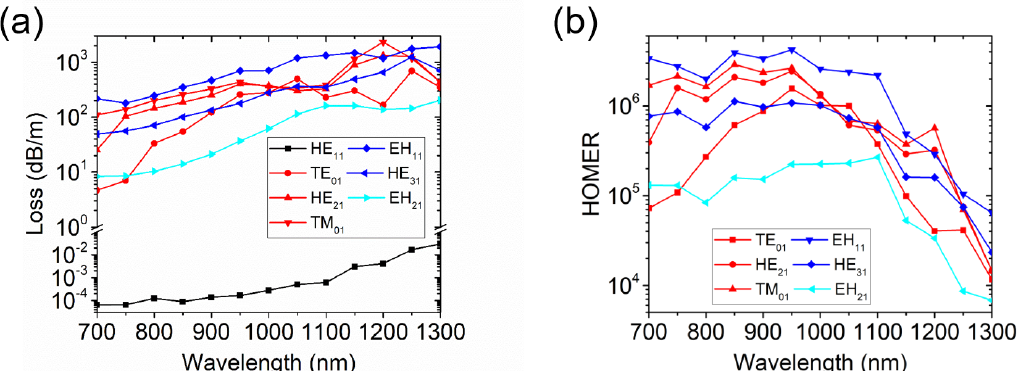
Figure 10. ( a ) The losses of the fundamental mode and HOMs as a function of wavelength in an NANF with hybrid extended cladding tubes; ( b ) The HOMERs of the fundamental mode and HOMs as a function of wavelength in an NANF with hybrid extended cladding tubes.